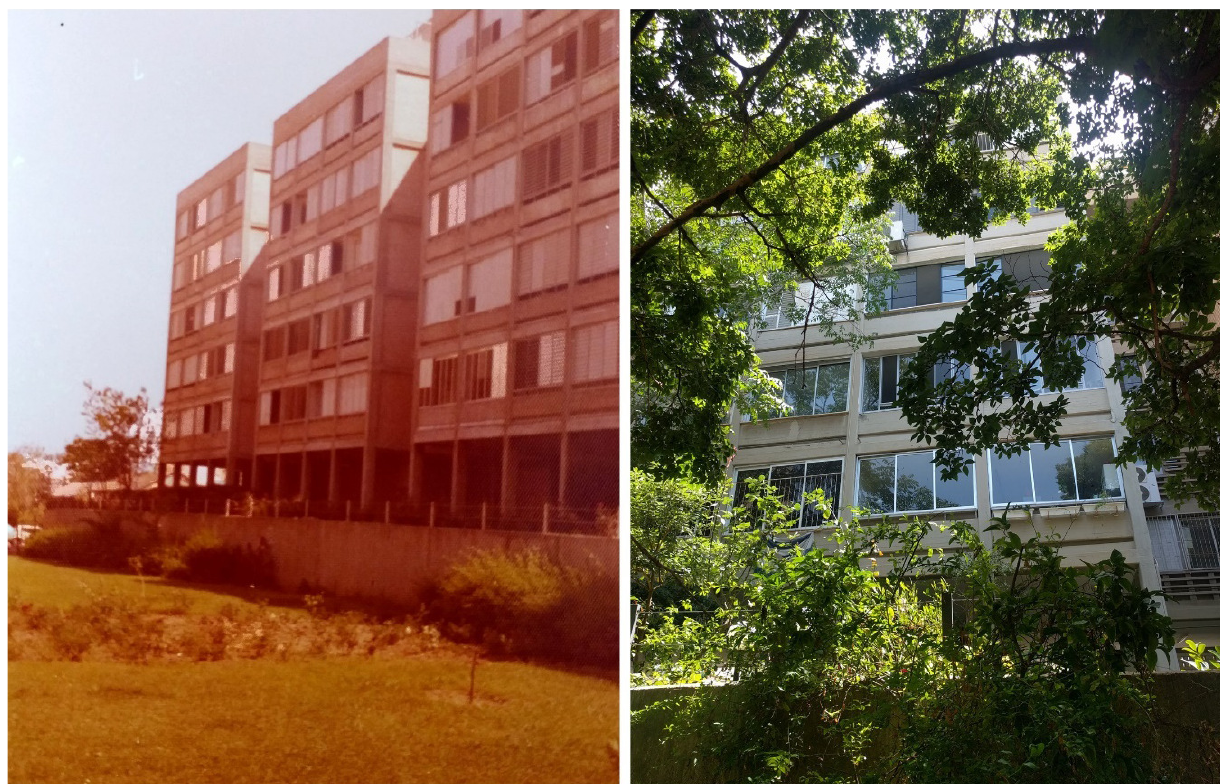
Figure 14. The central park, then and now. Left: Top row’s facade with original aluminium shutters on the balconies, 1970s. Right: Be’eri estate today, with vegetation hiding the top row’s facade. Source: Left photo courtesy of Nava